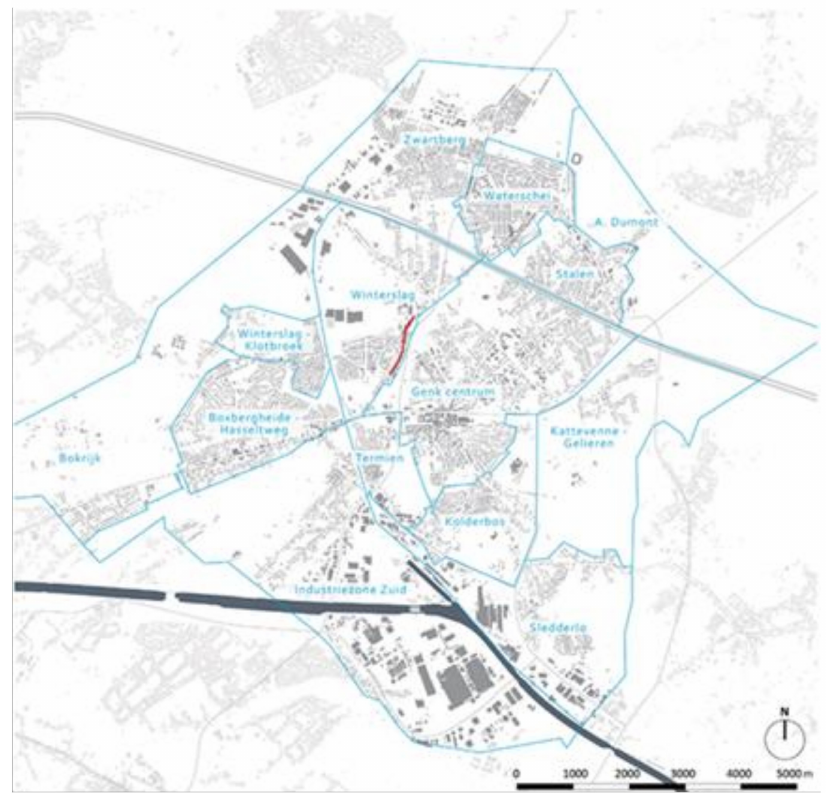
Figure 1. Position of the Vennestraat street (in red) in the city Genk. Source: Rapport Rasterstad Genk, BUUR,